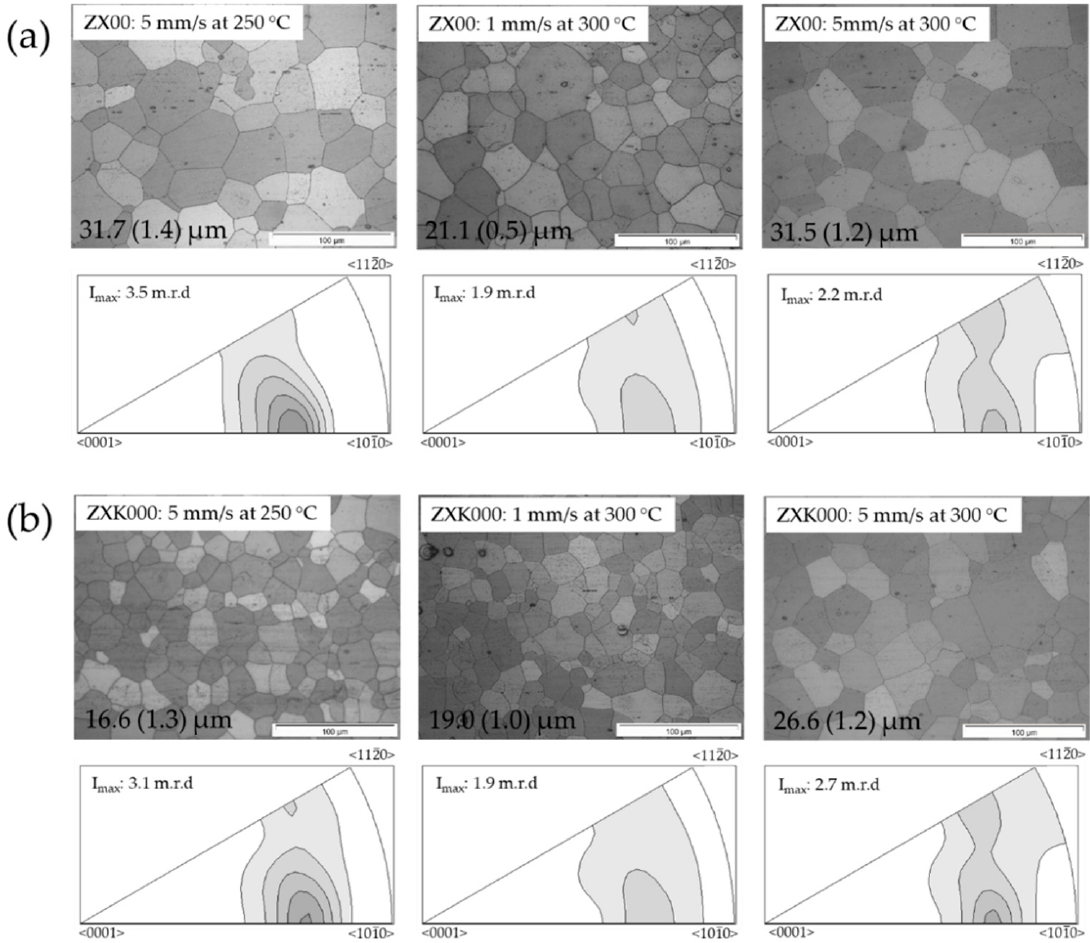
Figure 1. Micrographs from longitudinal sections (extrusion direction (ED) horizontal) and inverse pole figures in the extrusion direction of extruded Mg-Zn-Ca alloy (ZX00) at varied temperatures and extrusion speeds: ( a ) ZX00; ( b ) ZXK000.